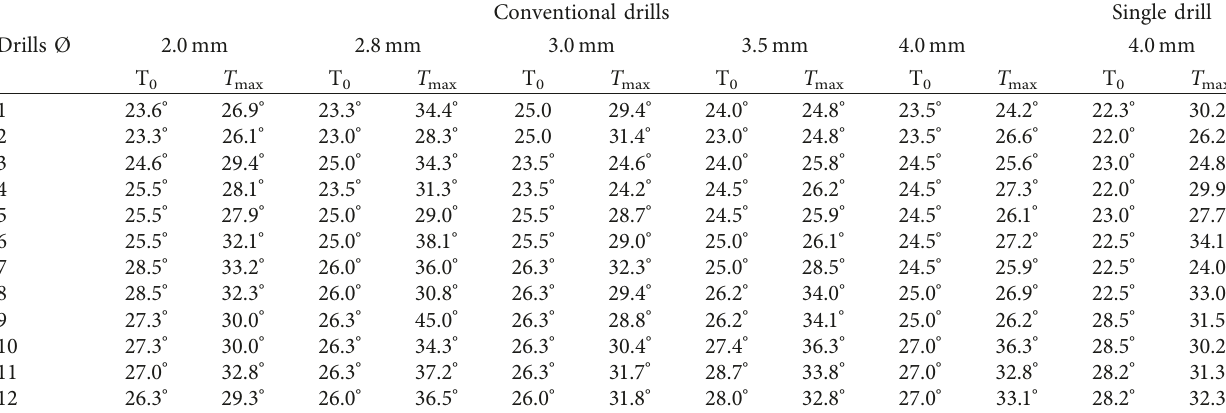
Table 3: The maximum change in temperature ∆ T � ( T